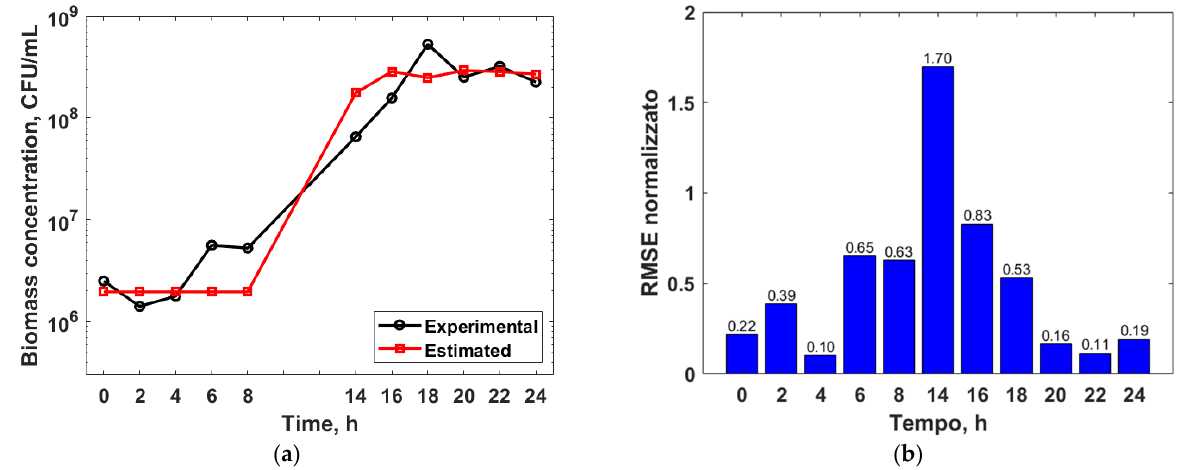
Figure 11. Genetic algorithm optimization by considering two regression terms and the response variable as a function of time, pH, and lactic acid concentration under pH control: ( a ) comparative trends and ( b ) normalized RMSE.